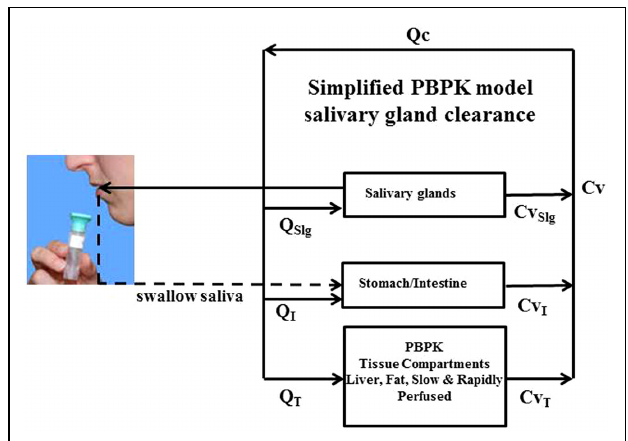
FIGURE 2 | Schematic model illustrating physiologically based pharmacokinetic (PBPK) model structure for simulating in vivo salivary gland clearance of